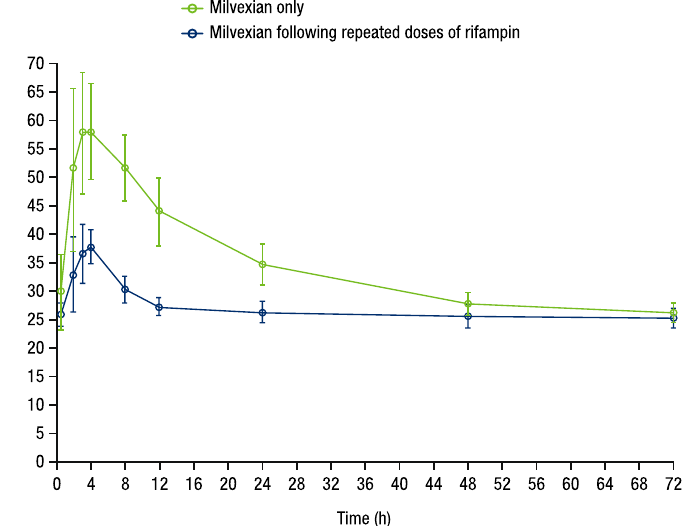
Figure 4. Mean (± SD) aPTT profile versus time profile. SD, standard deviation; aPTT, activated partial thromboplastin time.